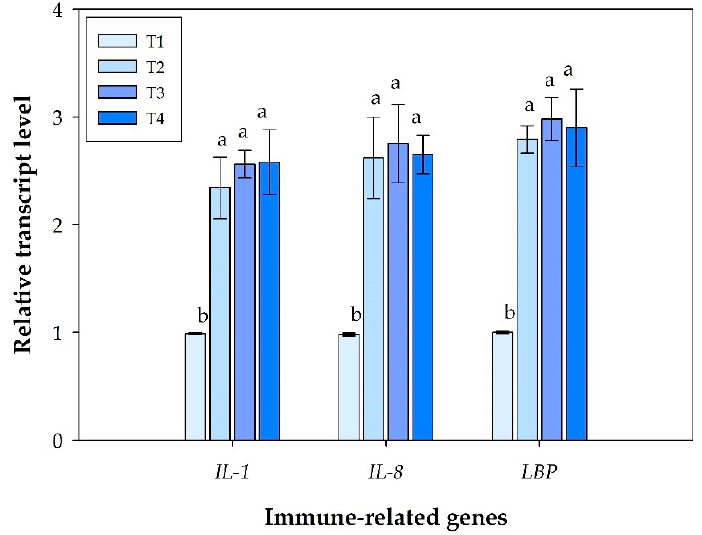
Figure 3. Comparative mRNA transcript levels of three immune-related genes (IL-1, IL-8, and LBP) in the livers of the vaccinated and control fish post-immunization. The 18S rRNA was used as an internal control gene. Significant differences between the treatment groups are denoted by different letters ( p < 0.05).